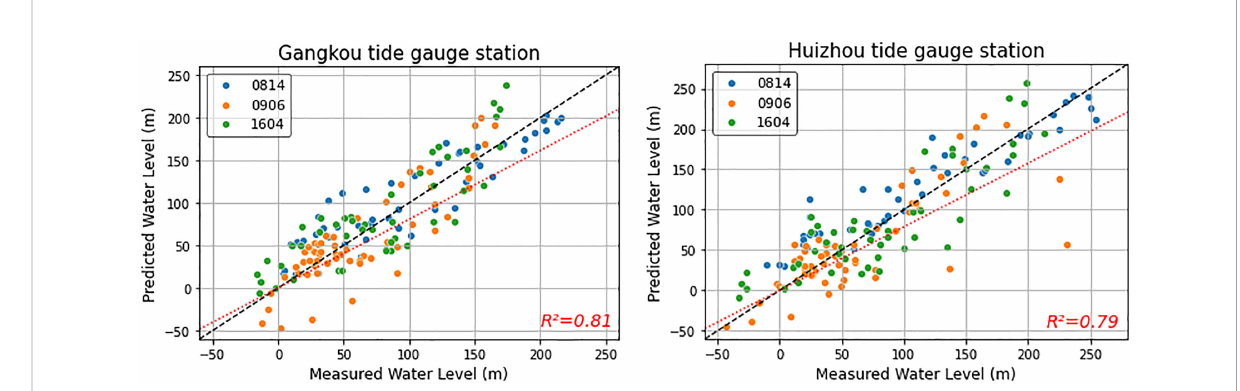
FIGURE 5 R-Squared between measured and predicted water elevations (astronomic tides and storm surges) during typhoon Hagupit (No. 0814), Molave (No. 0906), and Nida (No.